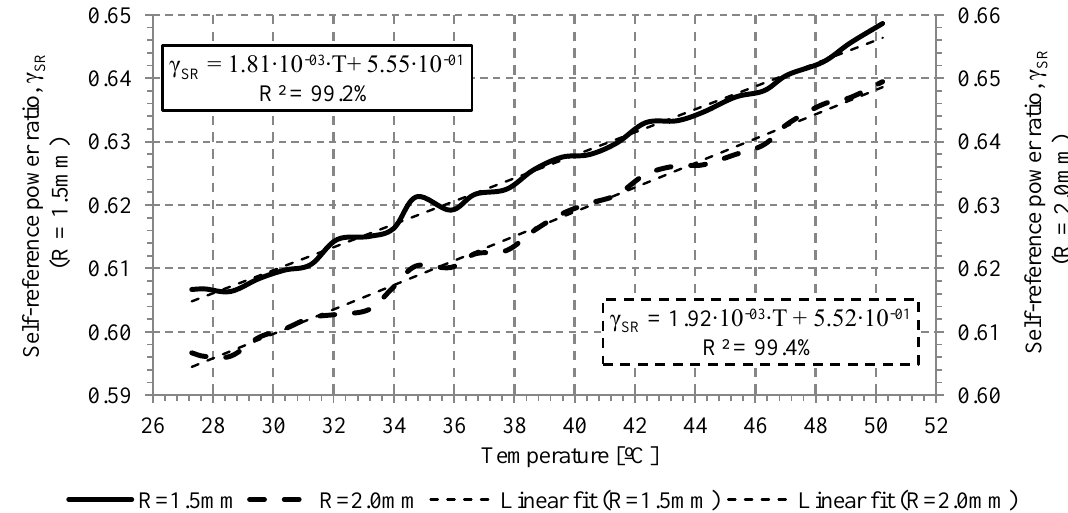
Figure 6. Self-reference output power ratio versus temperature for different bend